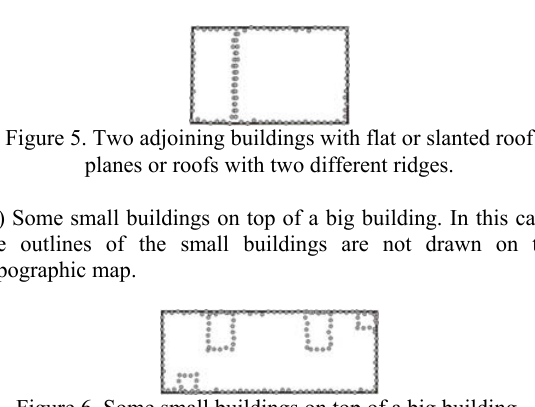
Figure 5. Two adjoining buildings with flat or slanted roof